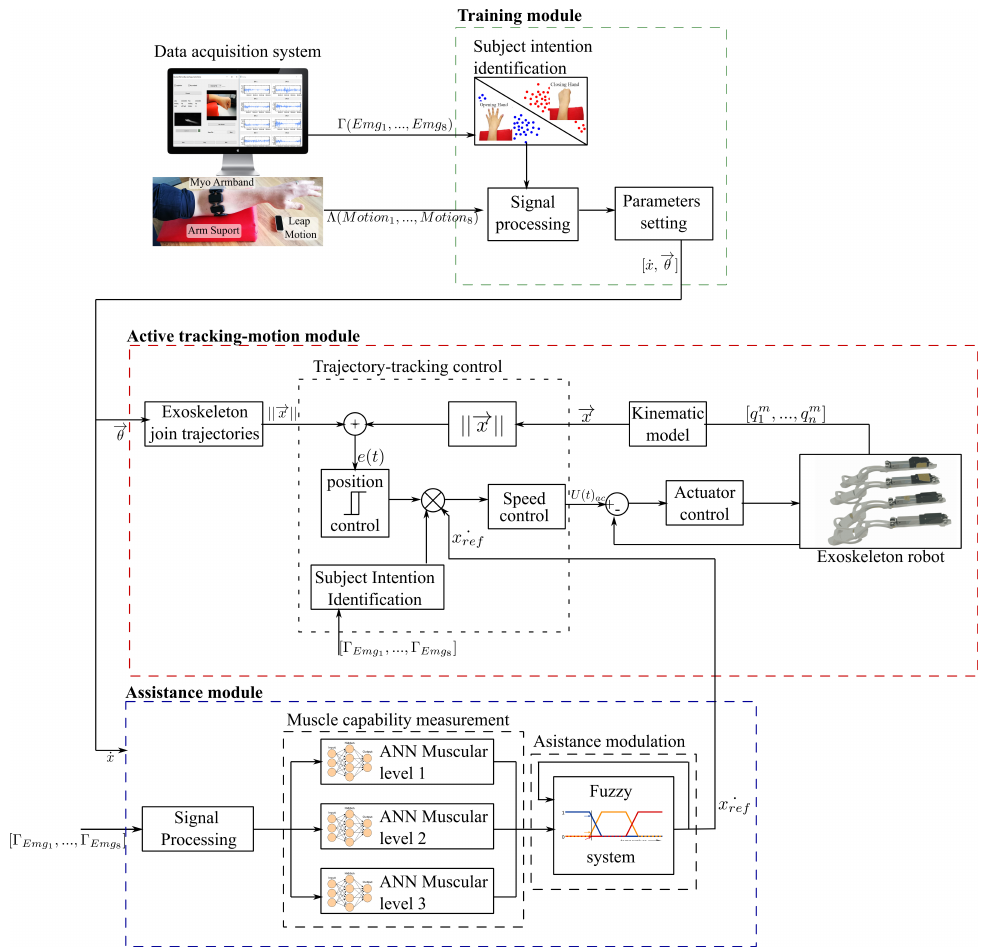
Figure 2. Proposed assistance control architecture based on the “assist-as-needed” paradigm. Three main modules are defined for training, active tracking-motion, and muscle capability